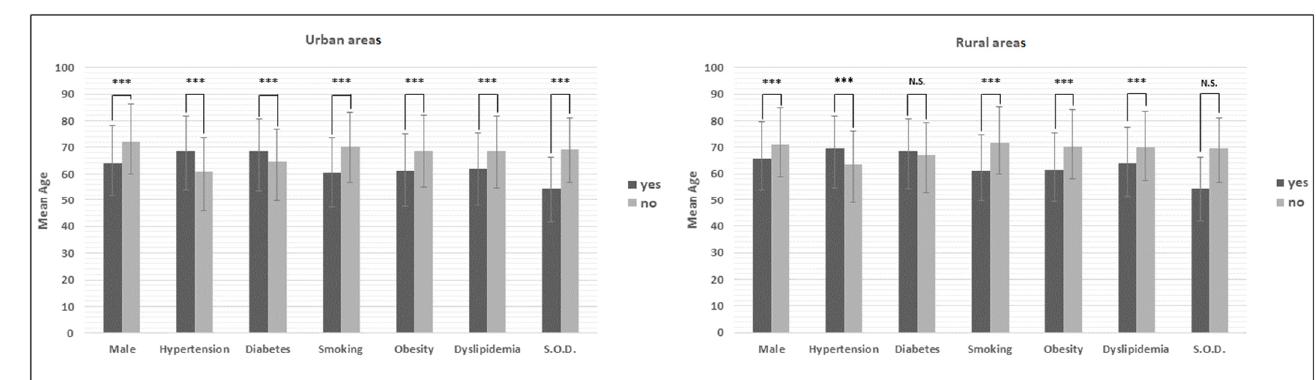
Figure 1. The onset age of AMI with and without conventional risk factors by area. N.S.: no significant difference ( p ≥ 0.05). ***: p < 0.001. Error bar: standard deviation.